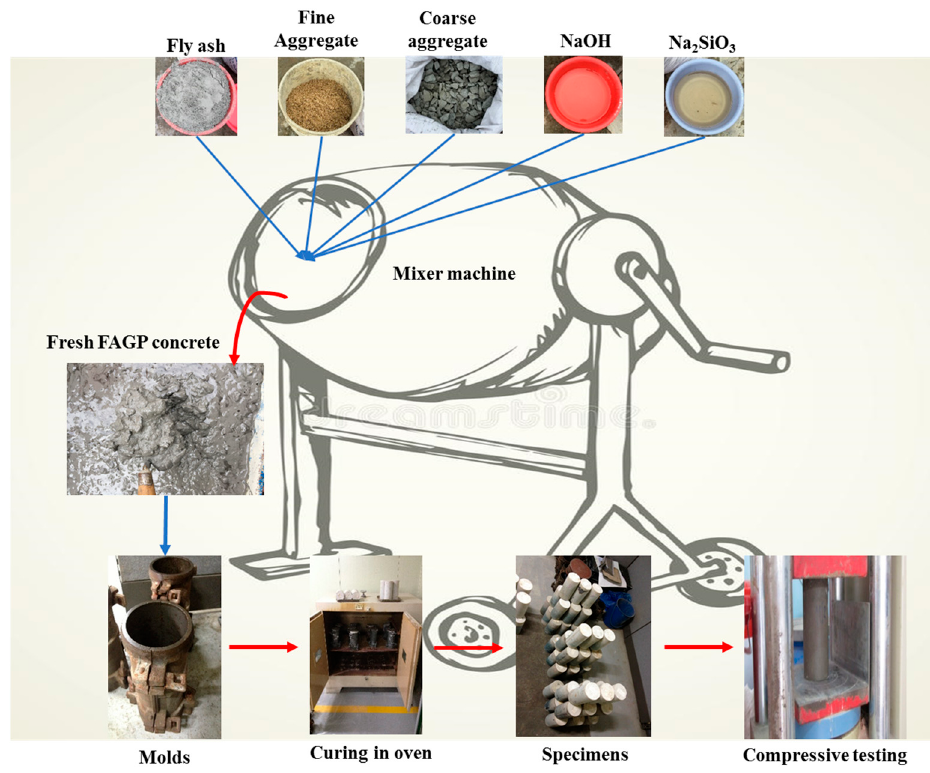
Figure 4. Schematic illustration of experimental works.